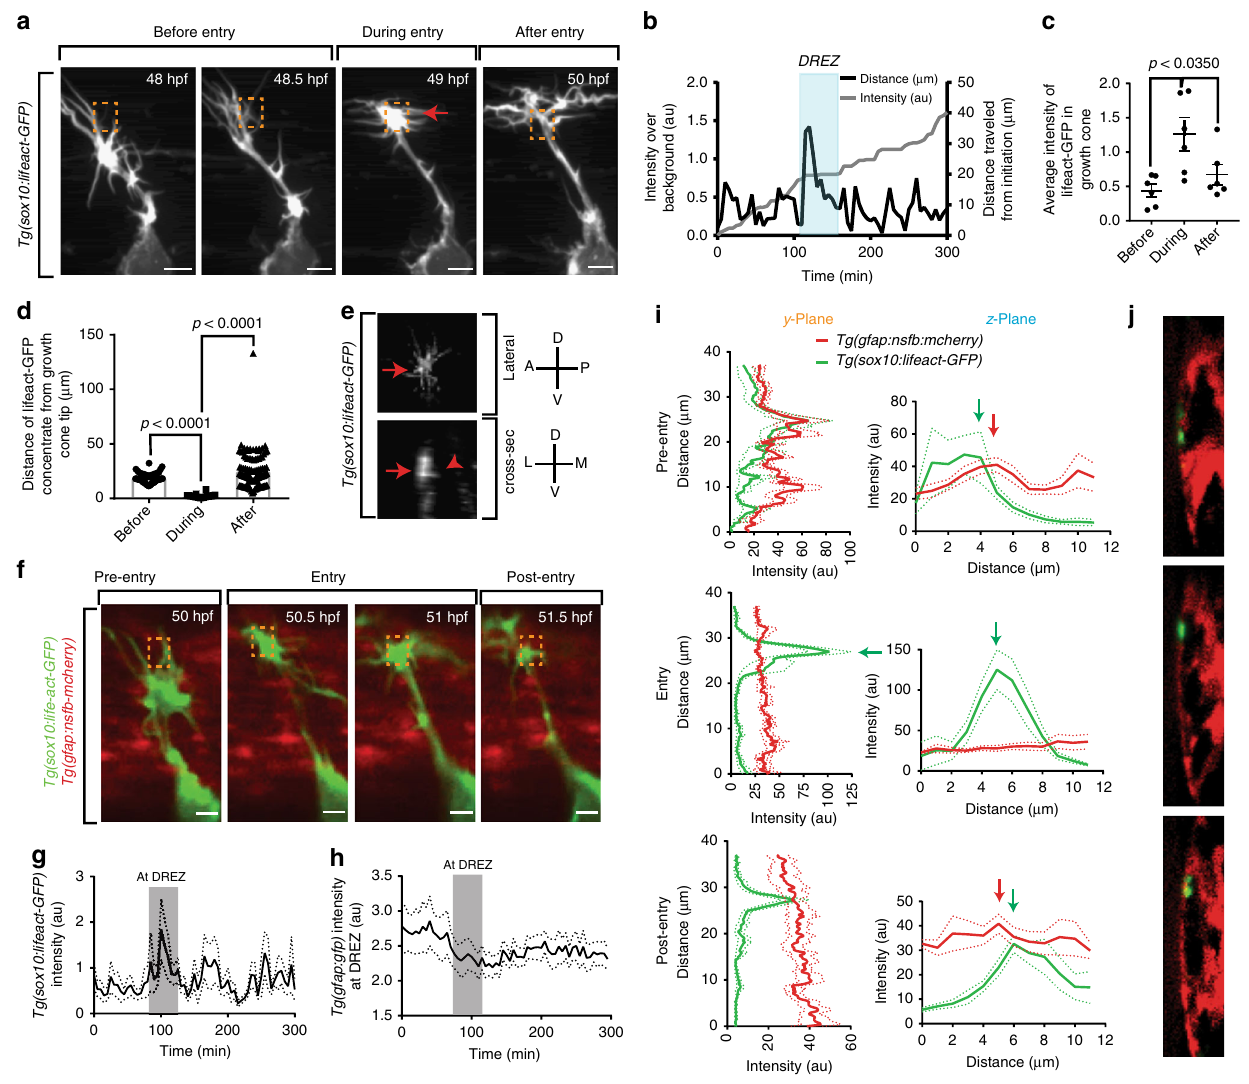
Fig. 3 An actin-rich structure forms in pioneer axons during spinal entry. a Confocal z -projection frames from a 24-h time-lapse starting at 48 h post fertilization (hpf) of Tg(sox10:lifeact-GFP ) zebra fi sh showing navigation of the pioneer axon into the spinal cord. Actin accumulates in the central growth cone speci fi cally at the dorsal root entry zone (DREZ). Red arrows denote the actin-rich structure at the tip of the growth cone. Orange dotted box denotes DREZ. Entry occurs at 50 min. b Representative intensity pro fi le of Lifeact-GFP at the growth cone (left y -axis, black line) and distance traveled by the growth cone (right y -axis, gray line). Actin concentration speci fi cally occurs during stalling and entry. Shaded blue box denotes the period of axon entry at the DREZ. c Quanti fi cation of average intensity of Lifeact-GFP at the growth cone before, during, and after entry to the spinal cord. SEM is shown, n = 6. d Distance of Lifeact-GFP concentrate form the tip of the growth cone before, during, and after entry to the spinal cord. SEM is shown, n = 6. e Deconvolved confocal images of actin-rich structures in Tg(sox10:lifeact-GFP) animals in lateral and cross-sectional views demonstrating the basally projecting actin cluster at the DREZ. Red arrow denotes the same protruding actin concentrate. Red arrowhead denotes basally projecting lifeact-GFP protrusion. Compass shown to right of image denote directional locations on animal. D dorsal, V ventral, A anterior, P posterior, L lateral, M medial. f Confocal z -projection frames from a 24-h time-lapse starting at 48 hpf of Tg(sox10:lifeact-GFP ); Tg(gfap:nsfb-mcherry) zebra fi sh showing navigation of the pioneer axon into the spinal cord. Orange dotted box denotes DREZ. g Intensity pro fi le of Lifeact-GFP at the growth cone. Gray box denotes period of actin concentrate formation. SEM is shown, n = 11 pioneer growth cones. h Intensity pro fi le of Tg(gfap:nsfb-mcherry) at the DREZ. Gray box denotes period of actin concentrate formation in the growth cone. mCherry intensity at the DREZ speci fi cally decreases during actin accumulation in the growth cone. SEM is shown, n = 11 DREZ. i Intensity pro fi les of Tg(sox10:lifeact-GFP) and Tg(gfap:nsfb-mcherry) across the y - and z -planes of the growth cone in y -orthogonal images before, during, and after entry at the DREZ. The y - and z -planes determined as shown in Fig. 2b. White arrowhead denotes the glia limitans. Black arrowhead denotes the radial glia cell soma. SEM is shown, n = 11 DREZ. j The y -orthogonal images of used to create intensity pro fi les in ( i ). Scale bars denote 10 µ m. Tukey ’ s honestly signi fi cant difference (HSD) ( d